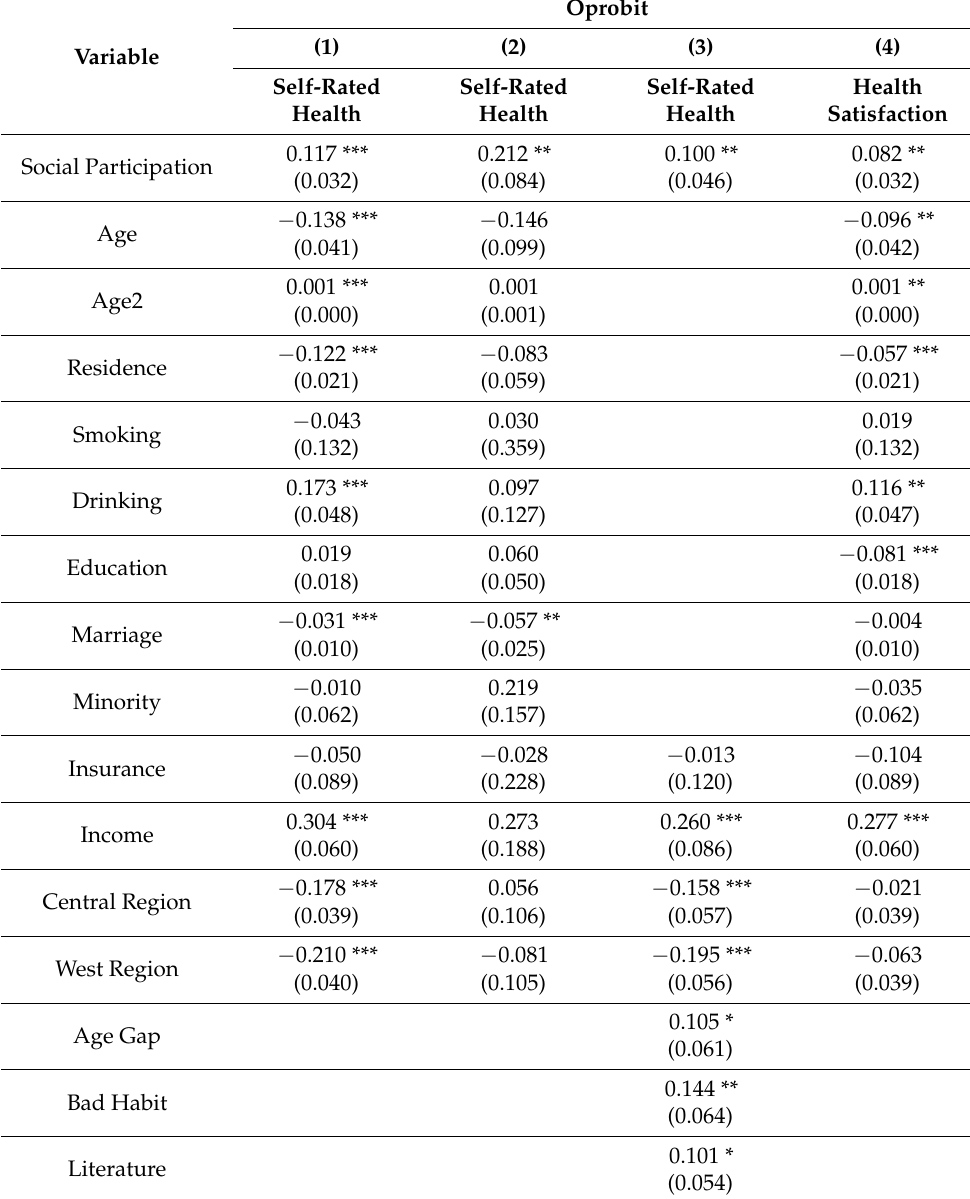
Table 7. Robustness